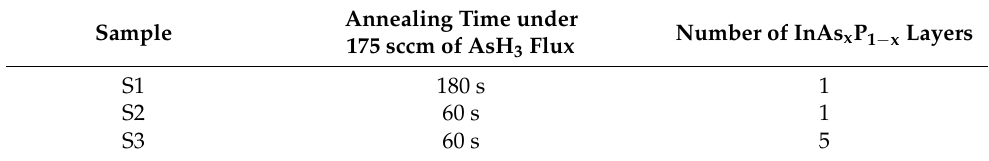
Table 1. Description of the Samples S1–S3.